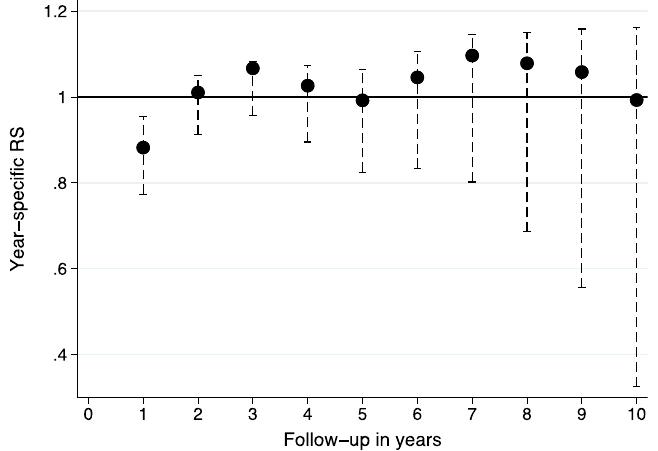
Figure 1. Year-specific relative survival (RS) (dots) with 95% confidence intervals (whiskers).